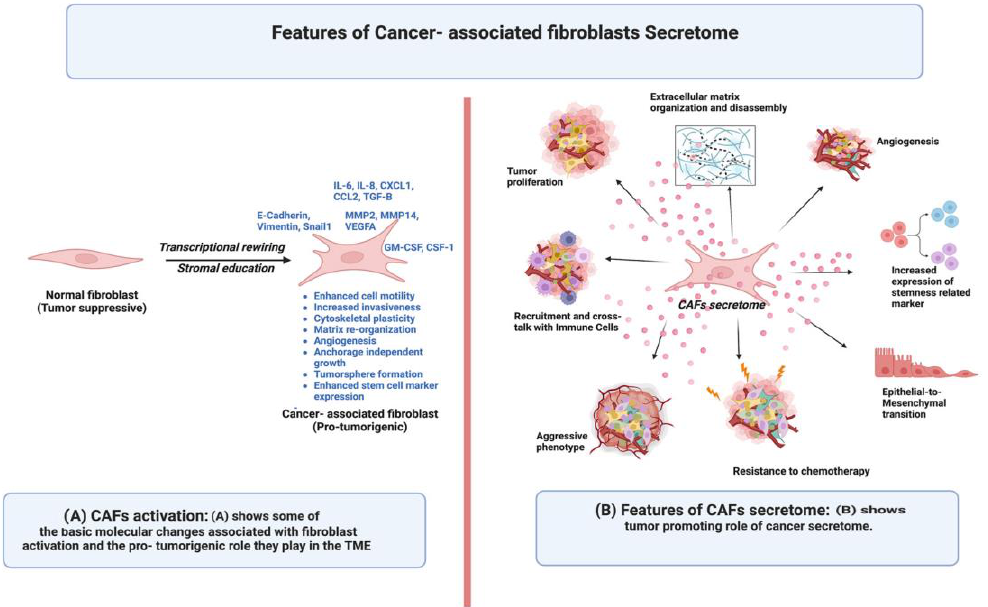
Figure 2. Features of CAFs secretome; ( A ) displays the process of fibroblast activation; ( B ) explains the diverse tumor-promoting features of the CAFs secretome.